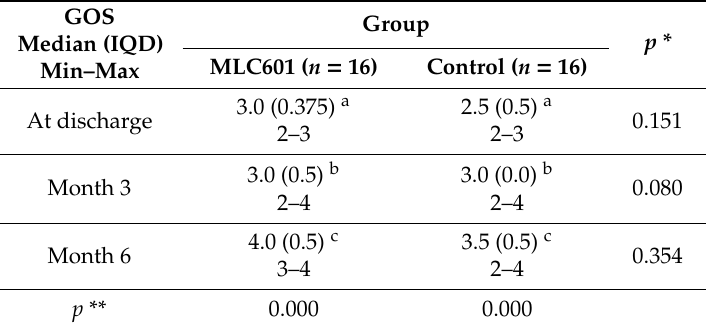
Table 2. Glasgow Outcome Scale (GOS)